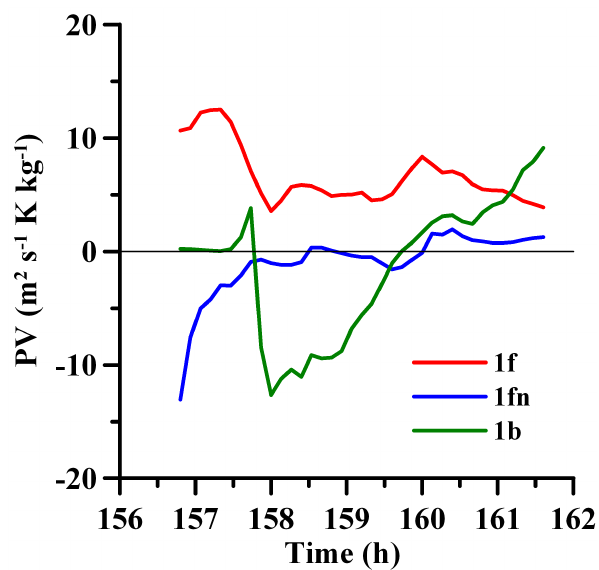
Fig. 8. Evolution of PV (m 2 s − 1 Kkg − 1 ) along parcel trajectory 1f (positive anomaly identified in Fig. 6), the trajectory originating from the nearest negative PV center (1fn), and the back-trajectory 1b (identified in Fig. 7) according to the simulation time. For lo- cations of these trajectories at various times, refer to Figs. 6 and 7 (trajectory 1fn is not shown but lies very close to trajectory